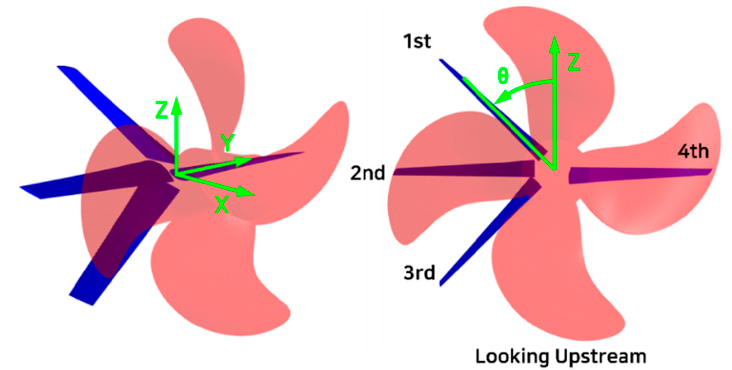
Figure 2. Typical arrangement and coordinate system of the stator blades of an asymmetric PSS.